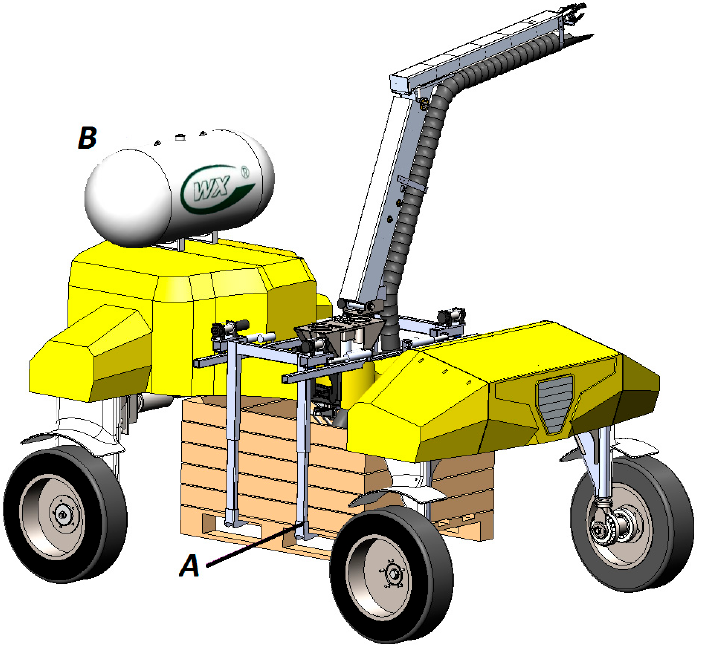
Figure 20. A device for automated capture and transportation of a fruit container ( A ); and tank with liquid ammonia ( B ). liquid ammonia ( B